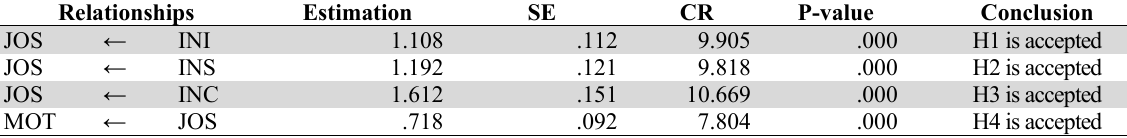
Table 2 The results of testing the relationship among the concepts (Standardized) Relationships Estimation SE CR P-value Conclusion